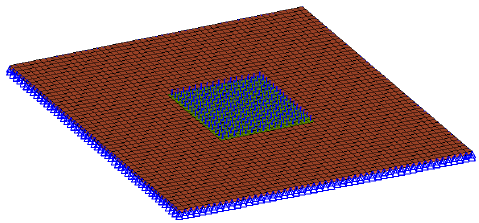
Figure 2. Boundary and loading conditions of the square plate model.